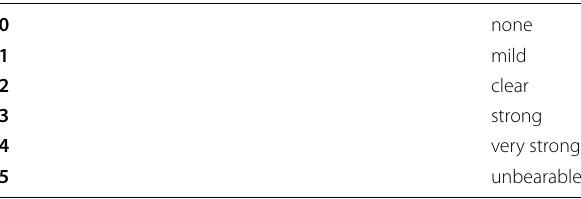
Table 2 Scoring table to describe the symptom severity of long- haul COVID